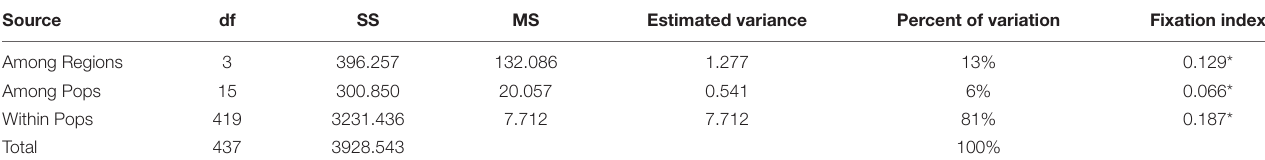
TABLE 3 | Analysis of molecular variance (AMOVA) for crown-of-thorns starfish in the South China Sea and Pacific Ocean from each 17 coral habitats with 4 geographical regional populations (South China Sea, Western Pacific, Pacific equatorial currents affected zone and Pacific insular atoll). Source df SS MS Estimated variance Percent of variation Fixation index